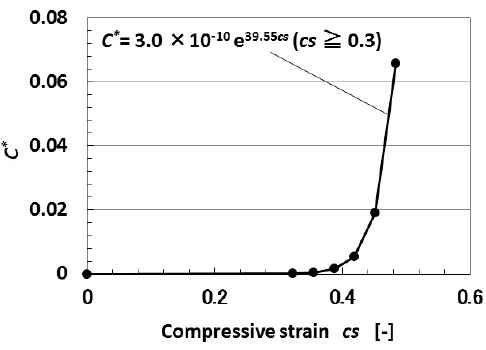
Figure 10. Theoretical results of dimensionless capacitance to compression by tunneling theory.